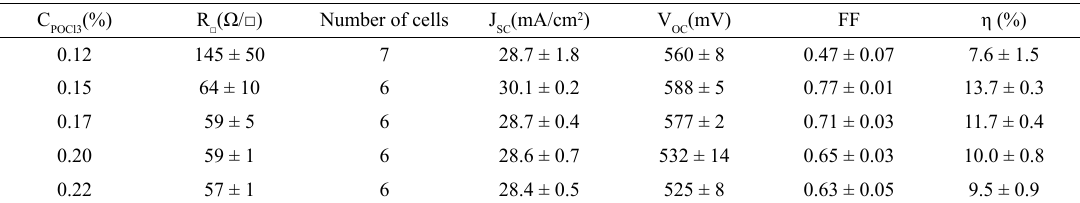
), short-circuit current density (J □ concentration. 3